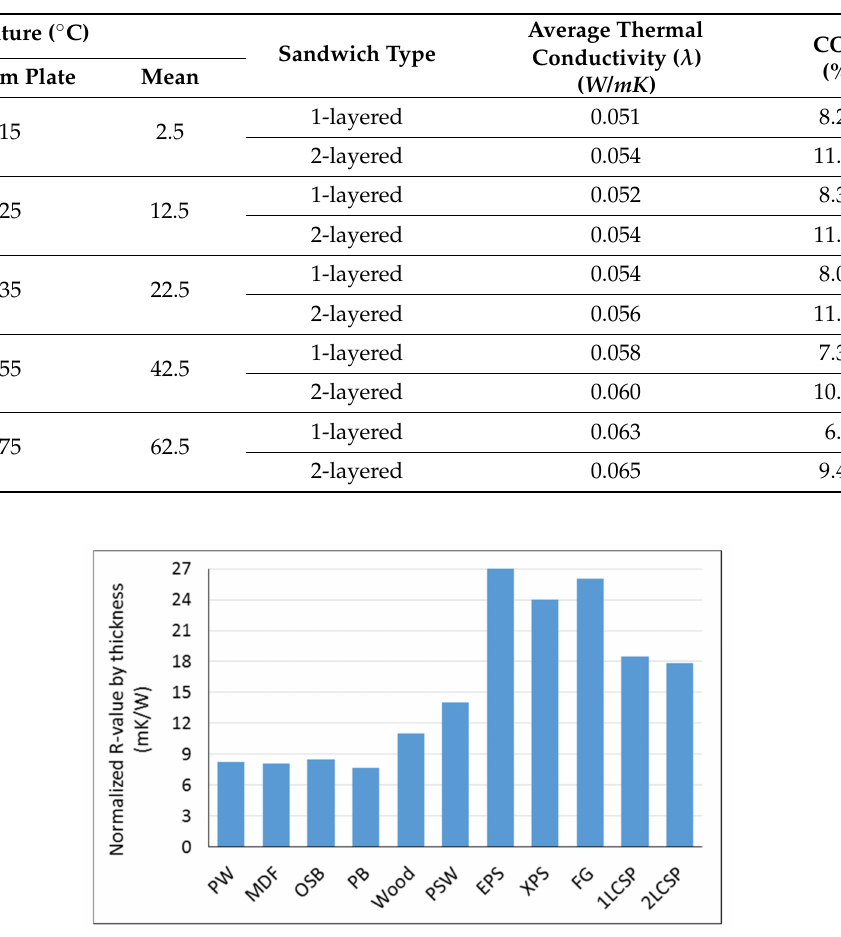
Figure 12. Comparison between normalized R-value of sandwich panel with corrugated core to those of commercially available wood-based and insulator products provided by Kawasaki and Kawai